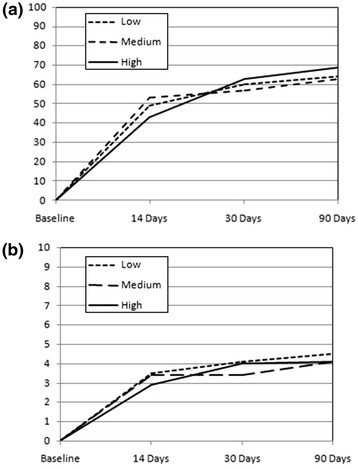
Resdualised*change scores compared between SBT risk groups for Total BQ (a) and Pain (b).